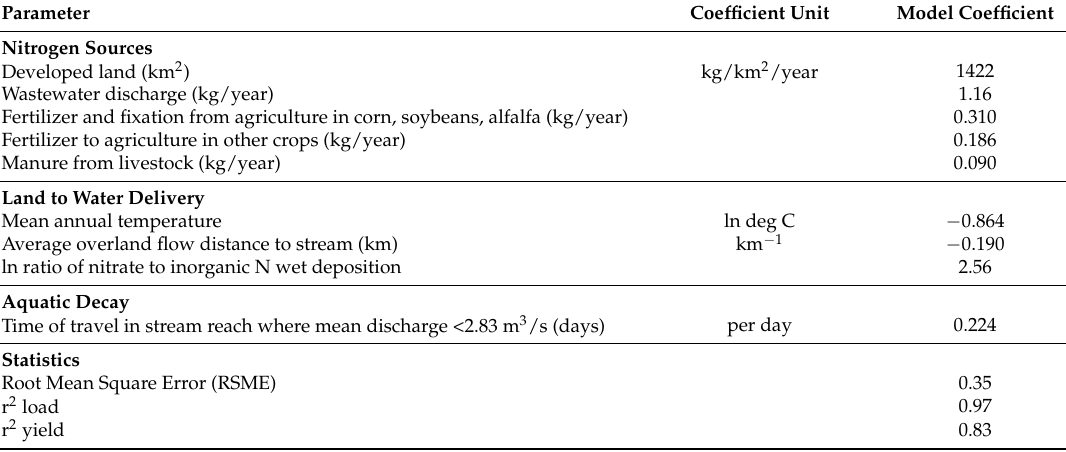
Table 3. Mid-Atlantic SPAtially Referenced Regressions on Watershed (SPARROW) model coefficients